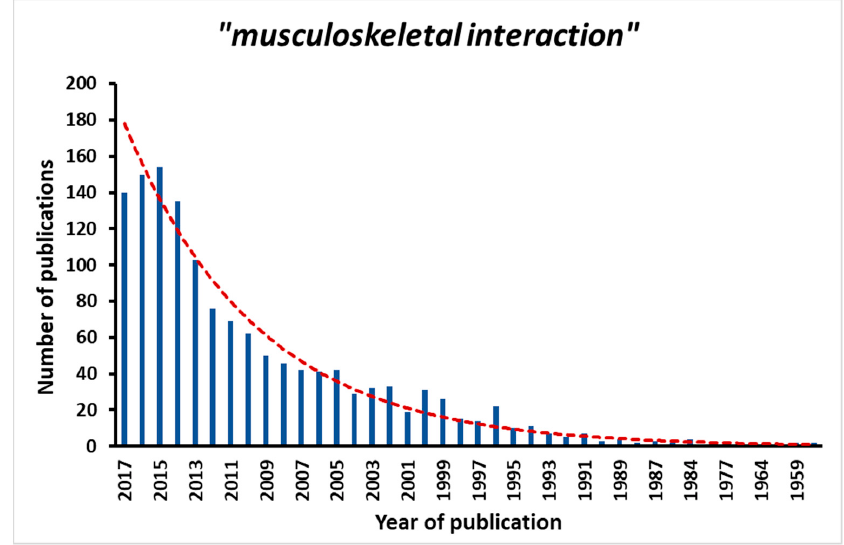
Figure 1. Using the search term “musculoskeletal interaction”, this graph demonstrated the increase in published papers in recent years with regard to the topic. The search has been made using PubMed, in September 2017.